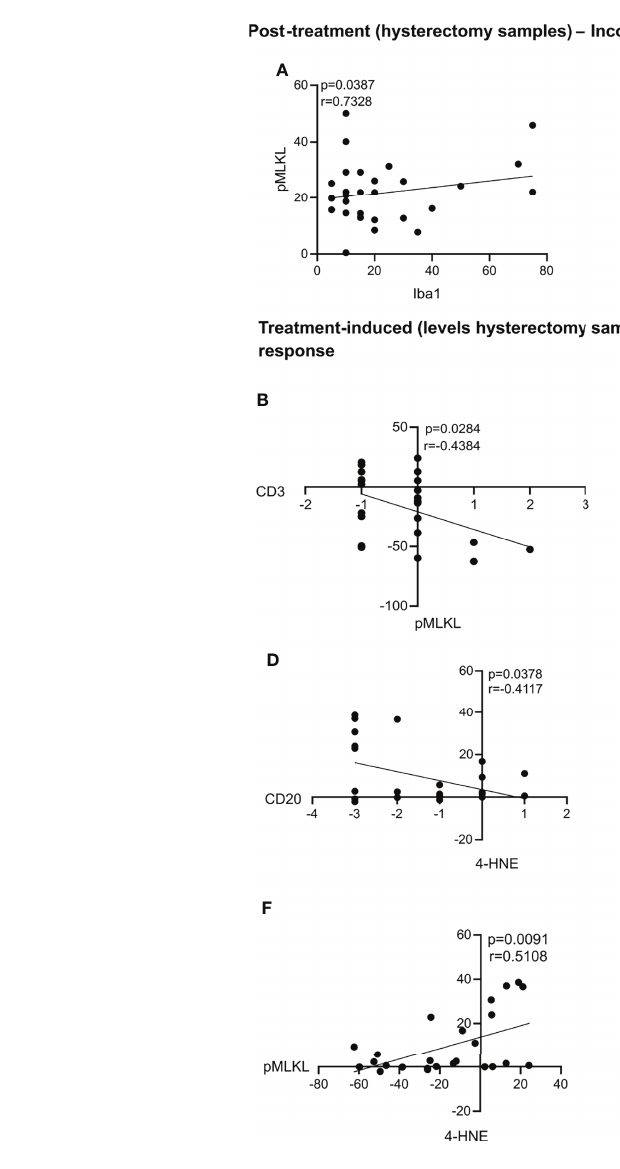
FIGURE 5 | Statistically signi fi cant correlations in the post-treatment samples and treatment-induced analysis for patients with an incomplete response. Statistically signi fi cant correlations were found between pMLKL and Iba1 in the post-treatment samples (A) . Correlations between the treatment-induced levels of pMLKL and CD3 (B) , GPX4 and CD3 (C) ; 4-HNE and CD20 (D) and FoxP3 (E) and pMLKL and 4-HNE (F) were also statistically signi fi cant. All p-values and correlation coef fi cients were evaluated with two-sided test of correlation (Genstat 64-bit Release 20.1) are indicated on the graphics which were generated with GraphPad (version